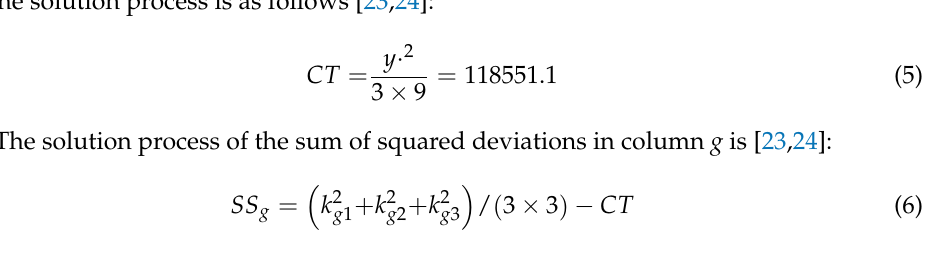
Table 5. Data processing results of the cutting force in the cutting direction.